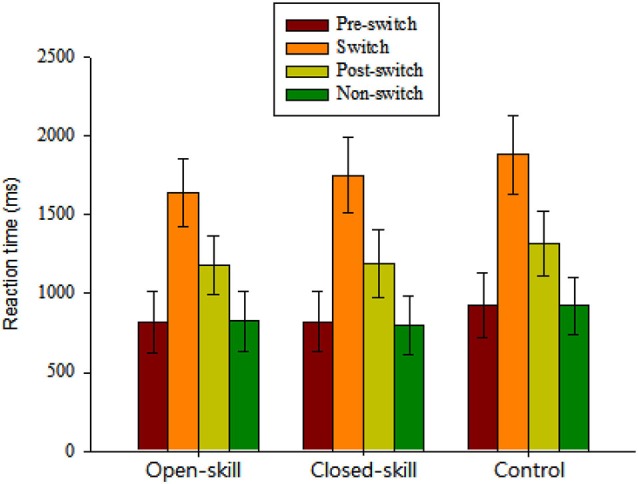
Grand mean RT data (mean ± SD) for pre-switch, switch, and post-switch trials during the heterogeneous blocks and non-switch trials during homogeneous blocks in the open-skill, closed-skill, and control groups (Note: The control group showed overall slowing relative to the two exercise groups across the four conditions; the open-skill group responded faster in the switch condition than the close-skill or control groups).